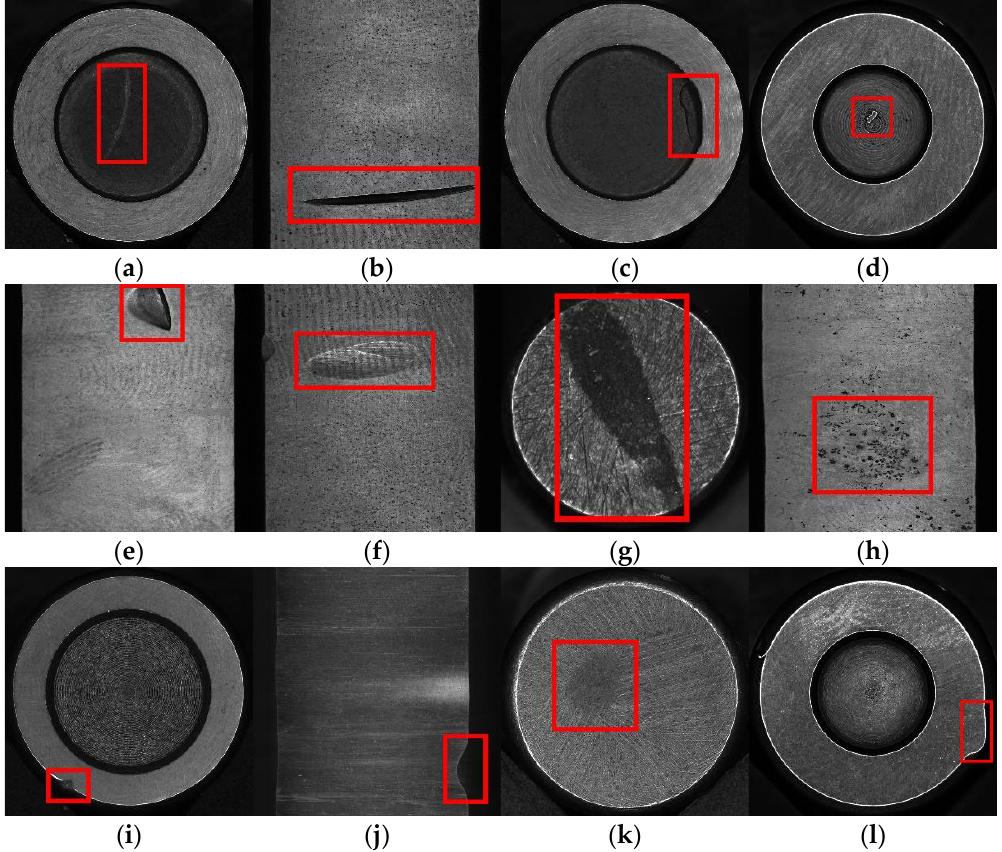
Figure 2. Common defects on the bearing roller: ( a , b ) Scratch; ( c – f ) damage; ( g , h ) corrosion; ( i , j ) material lacking at the chamfer; ( k ) grind lacking; and ( l ) stamp